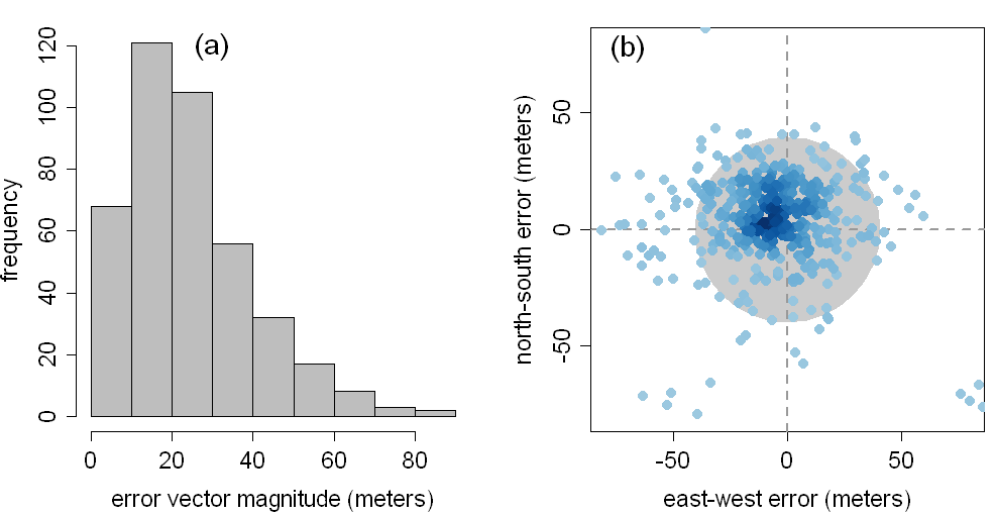
Figure 4. (a) Magnitude of horizontal error vectors for 412 control points (points from six cities with mean errors greater than 1 standard deviation from the global mean are not plotted). (b) Error vectors for 413 control points (23 large-magnitude error vectors are not plotted). The gray crosshair marks the origin of the error vectors (Landsat GeoCover), the blue density-shaded dots are termini (GE), and the gray ring describes the overall accuracy (39.7 meters RMSE).